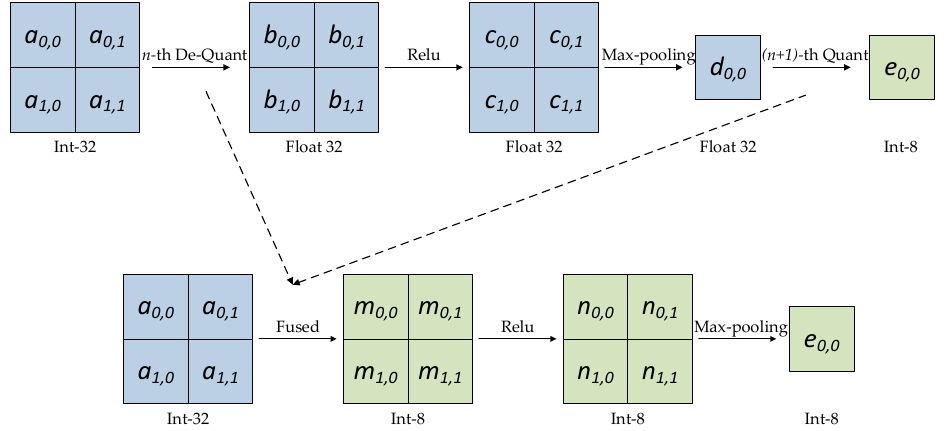
Figure 12. The process of generating element e 0,0 in general network inference and optimized network inference. a i , j is the output of the convolution module. b i , j , c i , j , and d i , j are the outputs of the de-quantization module (the n- th layer), ReLU module and Max-pooling module in general network inference, respectively. m i , j and n i , j are the outputs of the fusion module and ReLU module in optimized network inference, respectively. ‘Quant’ and ‘De-Quant’ refer to ‘quantized’ and ‘de-quantized’, respectively.